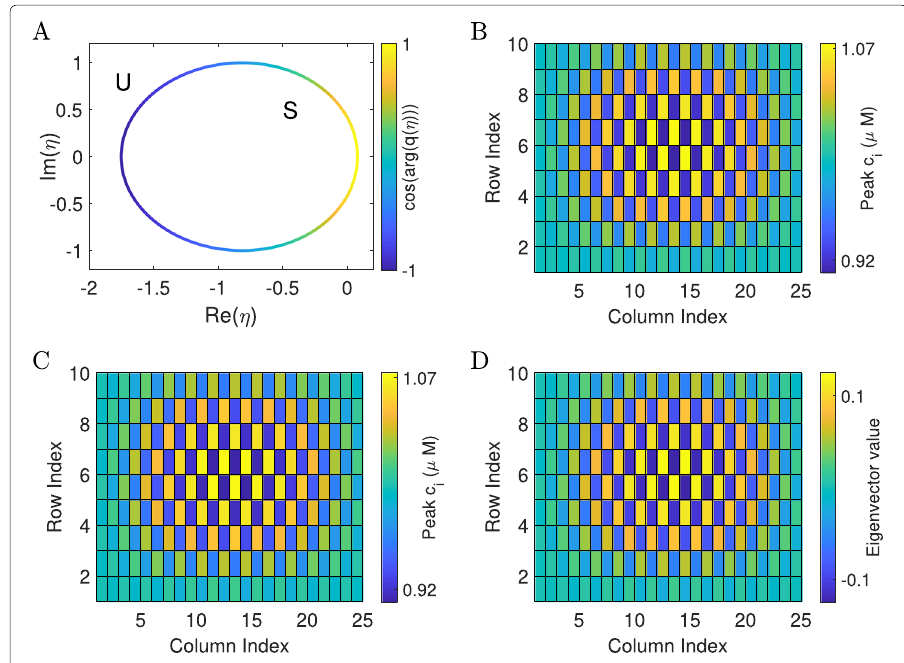
Fig. 2 a Zero-contour of the MSF for cytosolic coupling and T p = 0.9. The MSF is negative inside the ellipse, labeled by S, and positive outside, denoted by U. The colour represents the value of cos ( arg ( q (η))) . b , c Peak Ca 2 + concentration in the bulk on successive beats. d Eigenvector corresponding to the single eigenvalue λ k for which η = σλ k lies outside the ellipse. Here, σ =